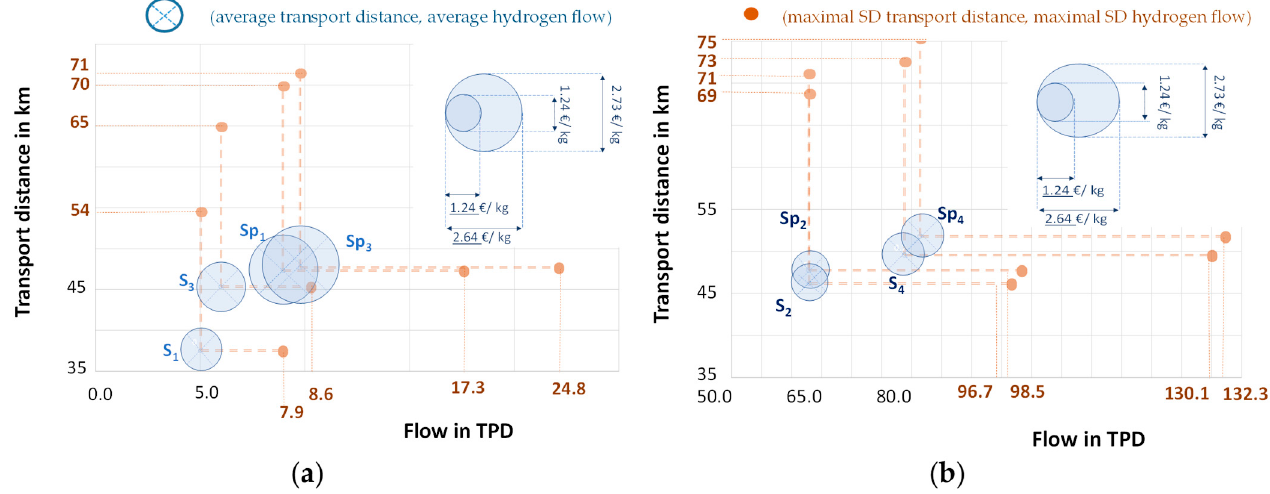
Figure 4. Average and maximum standard deviation (SD) of the transport distance and flow for low demand ( a ) and high demand scenarios ( b ).